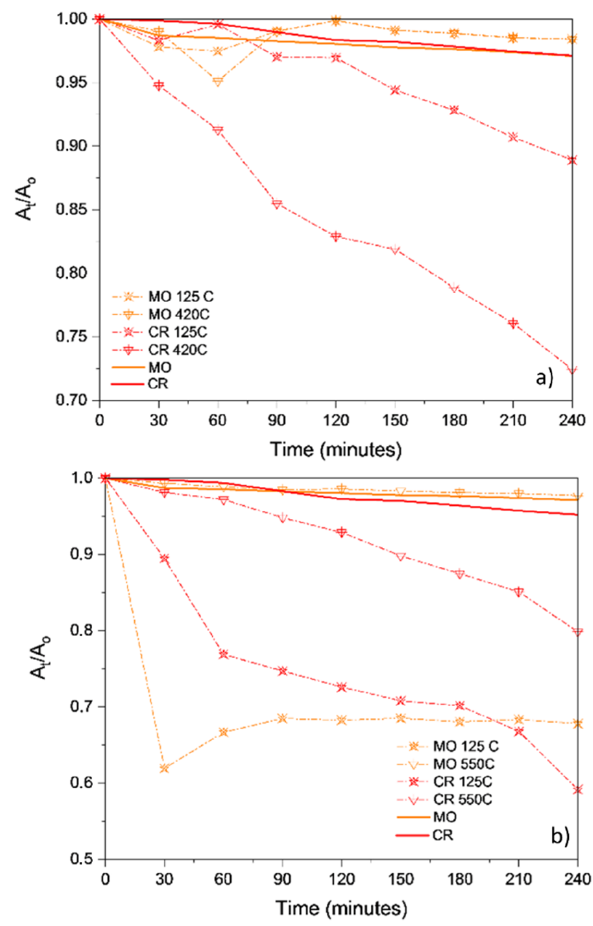
Figure 12. Photocatalysis of decomposition intermediates formed at various temperatures under nitrogen ( a ) and air ( b ) during the decomposition of Congo red. Table 7. Photocatalytic parameters in the decomposition of methyl orange and Congo red with intermediates forming in different